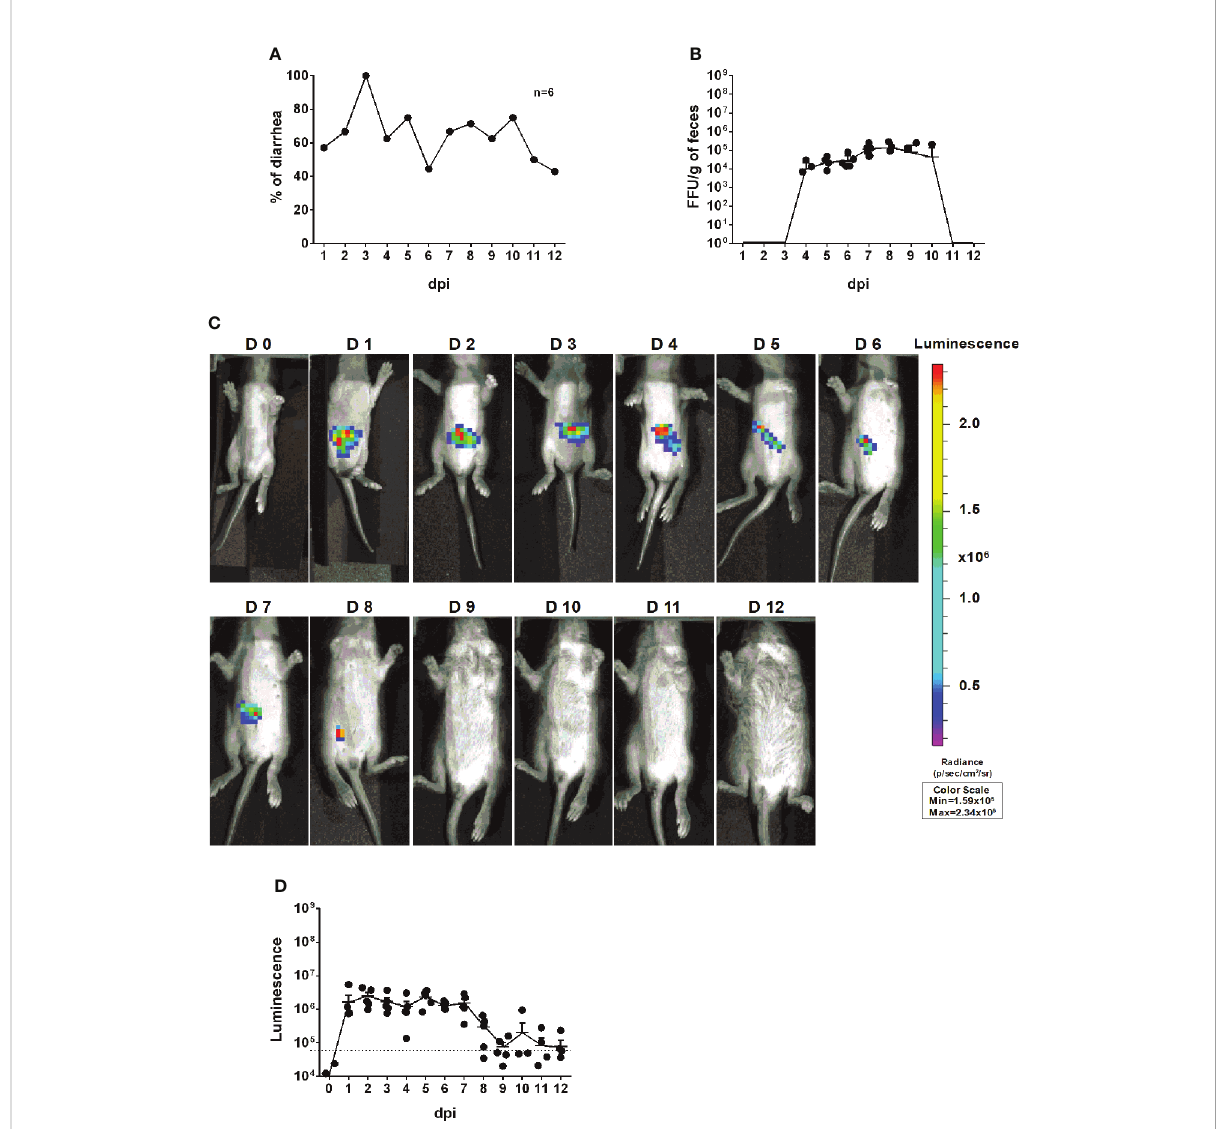
FIGURE 4 InfectivityandpathogenicityofrD6/2-2g-NLucinvivo . (A) Five-day-old129svmice(n=6)wereorallyinoculatedwith3.5×10 3 FFUsofrD6/2-2g-NLuc. Thediarrhearatewasmonitoredfrom1to12dayspostinfection. (B) ViralsheddinginstoolsampleswasdetectedbyanFFUassayandnormalizedtothe fecesweight. (C) RepresentativeimagesofrD6/2-2g-NLucinfectedpups(1to12days).Thebioluminescentsignalisexpressedinphotonspersecondper squarecentimeterpersteradian(p/sec/cm 2 /sr). (D) Quanti fi cationoftheluminescencein (C)